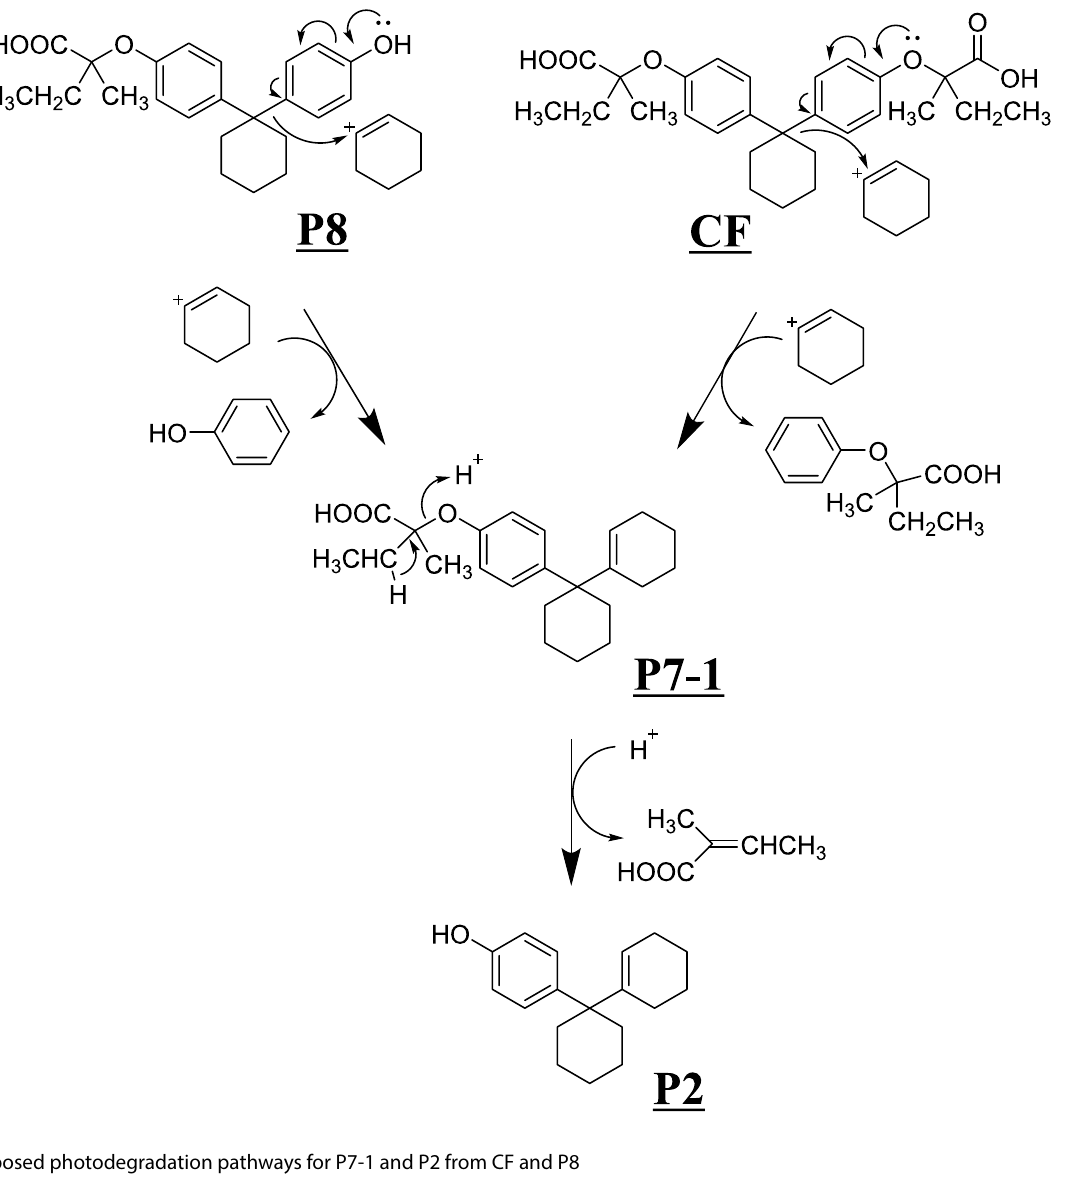
Fig. 7 Proposed photodegradation pathways for P7-1 and P2 from CF and